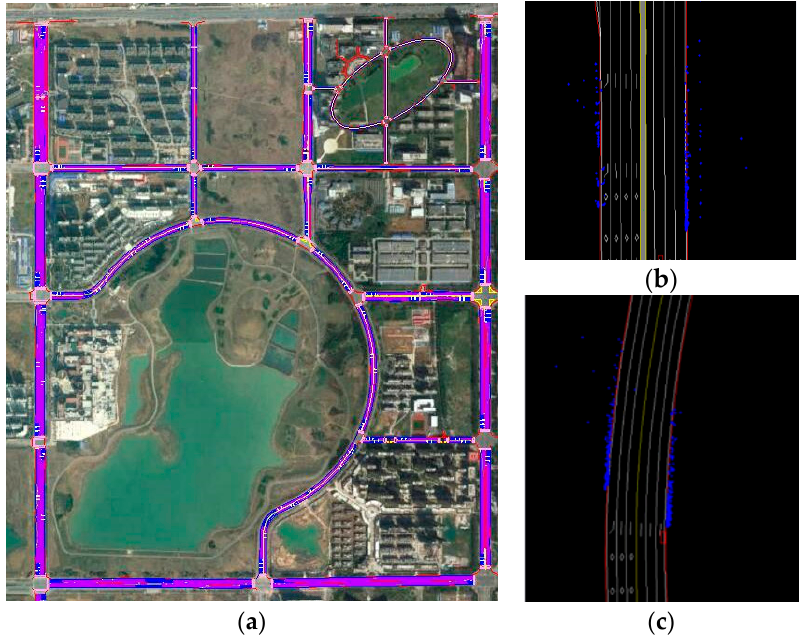
Figure 12. Testing roads. ( a ) Satellite map of testing roads which are represented with red lines and blue lines; ( b ) a straight road where red lines are road curves, white lines are lane marks and blue points represent obstacles; ( c ) a winding road.